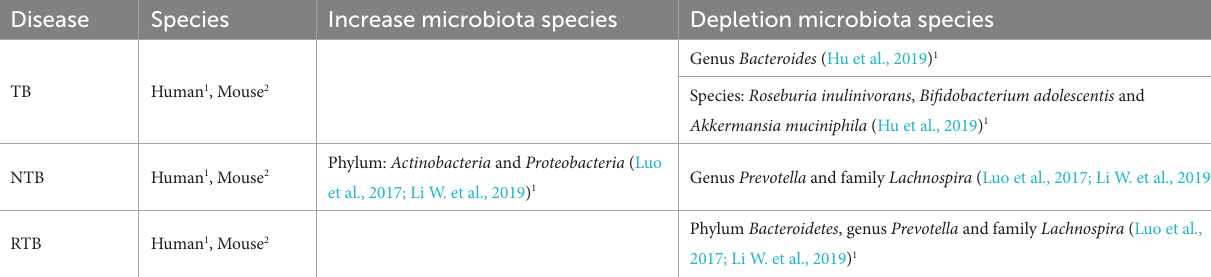
TABLE 3 Tuberculosis and alteration of the gut microbiota composition.